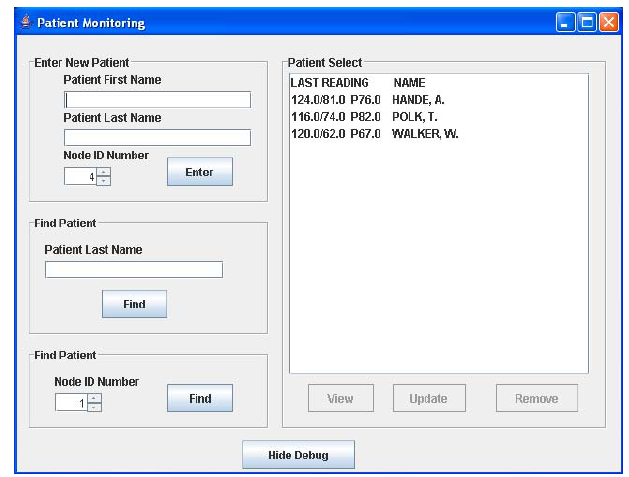
Figure 5a. GUI main window.